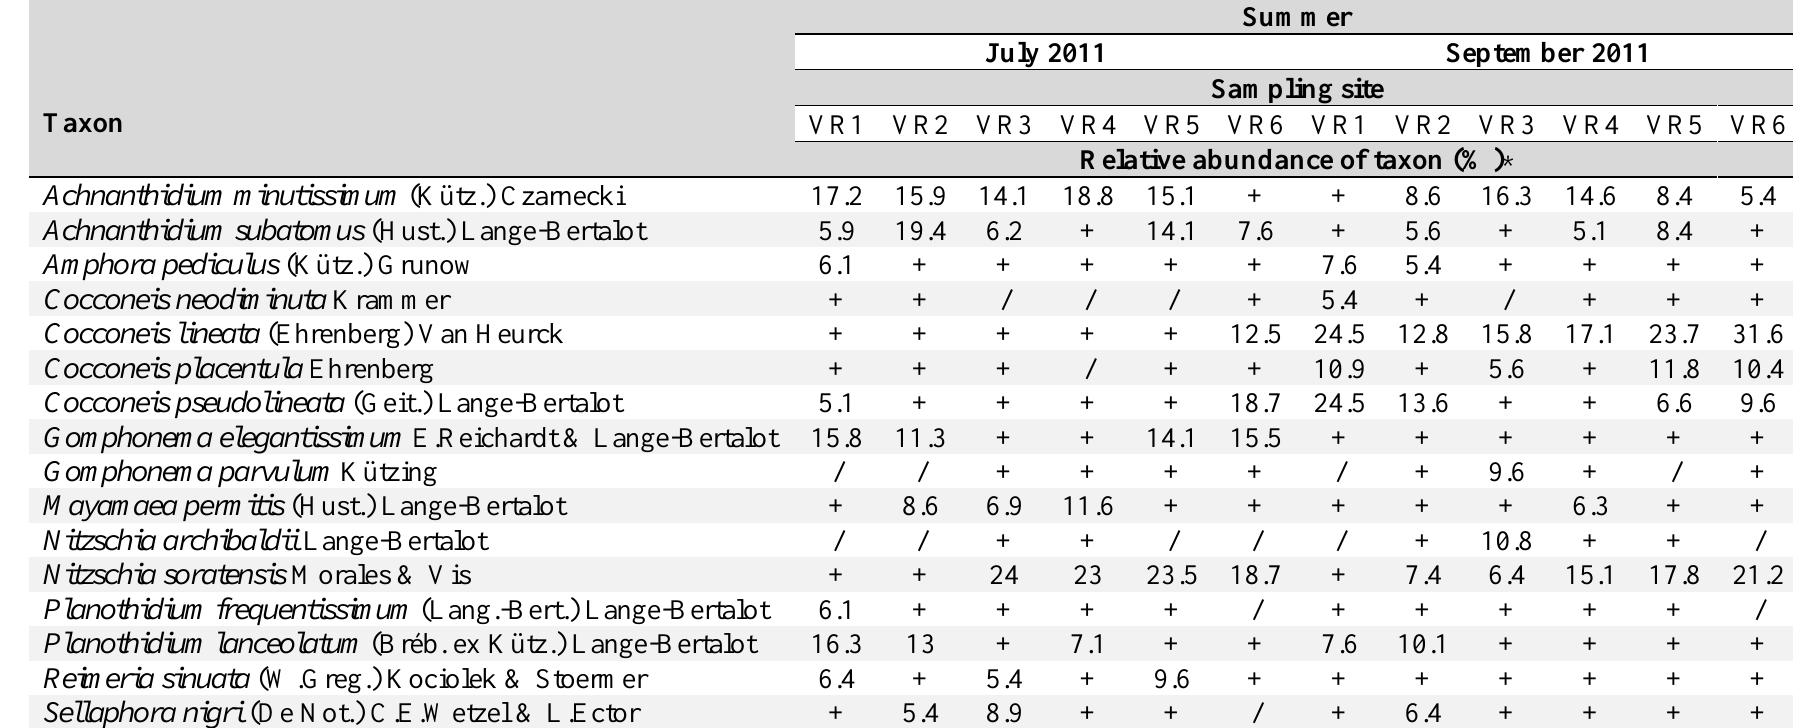
Table 2. Relative abundance of diatom taxa (%) present in the epilithic diatom community in the Vrla River during the summer period (July and September